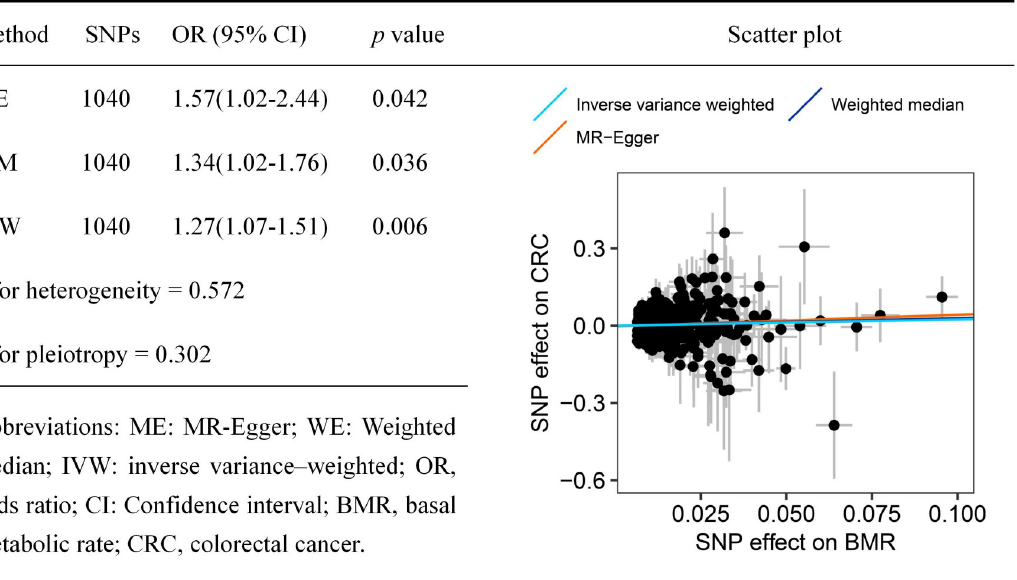
Fig 2. Mendelian randomization results for the relationship between basal metabolic rate and colorectal cancer risk.